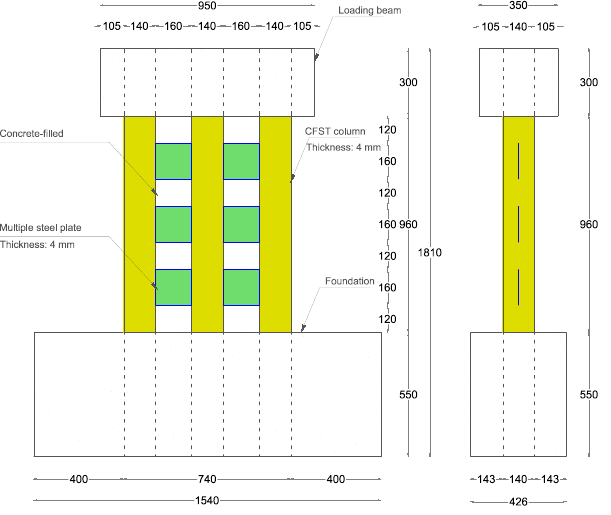
Figure 1. General dimensions of the shear wall structure investigated in this work, adapted from Qiao et al.